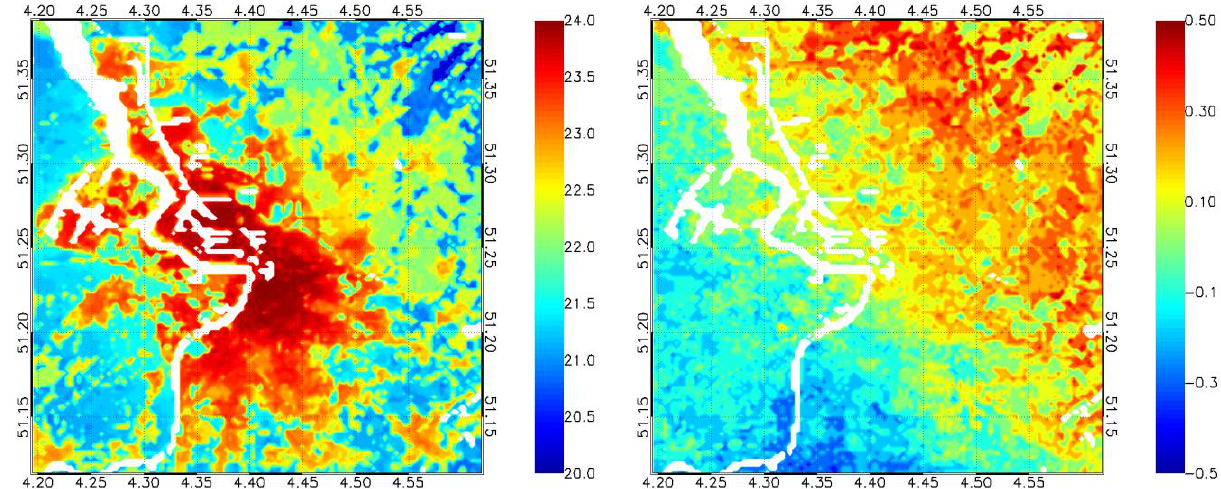
Figure 10. Temperature indicator for Antwerp for the period 2081–2100, based on the statistical method ( left ) and the differences with the map in Figure 9, based on the 11 GCM-driven simulations ( right